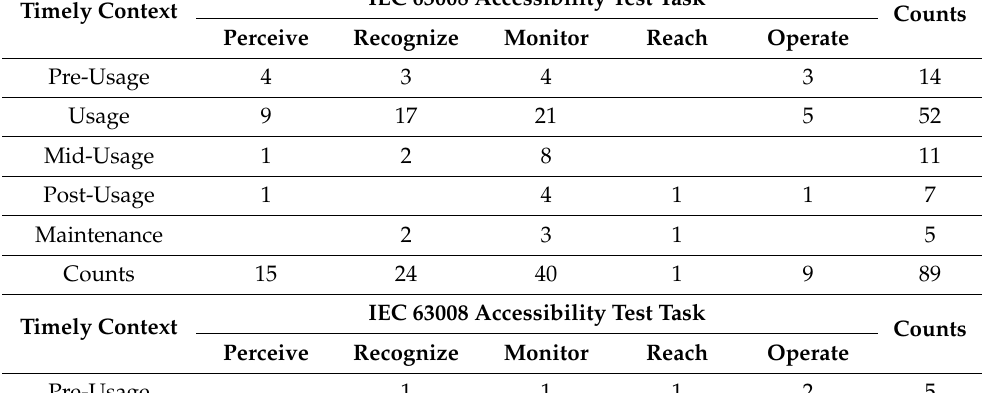
Table 4. Accessibility issues counted for visually impaired/hearing impaired/spinal-cord im- paired/elderly